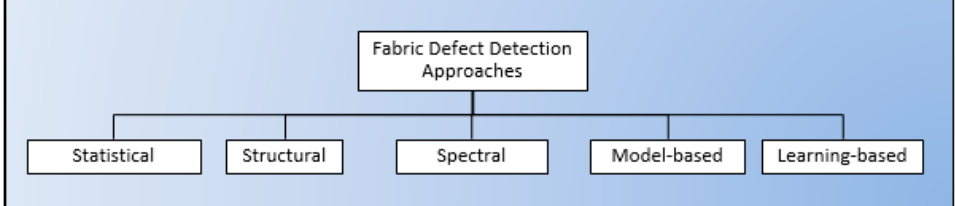
Figure 1. Fabric defect detection approaches.